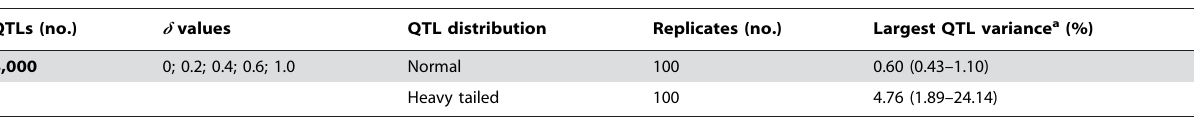
Table 1. Simulation